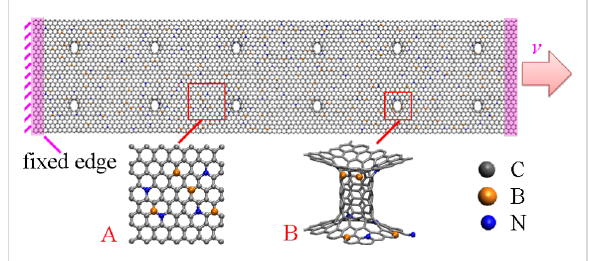
Figure 1: Schematic view of the model GNHS-2.0%N2.0%B. Inset ‘A’ shows the boron and nitrogen atoms located at the graphene layer, inset ‘B’ shows the boron and nitrogen atoms located at the connecting